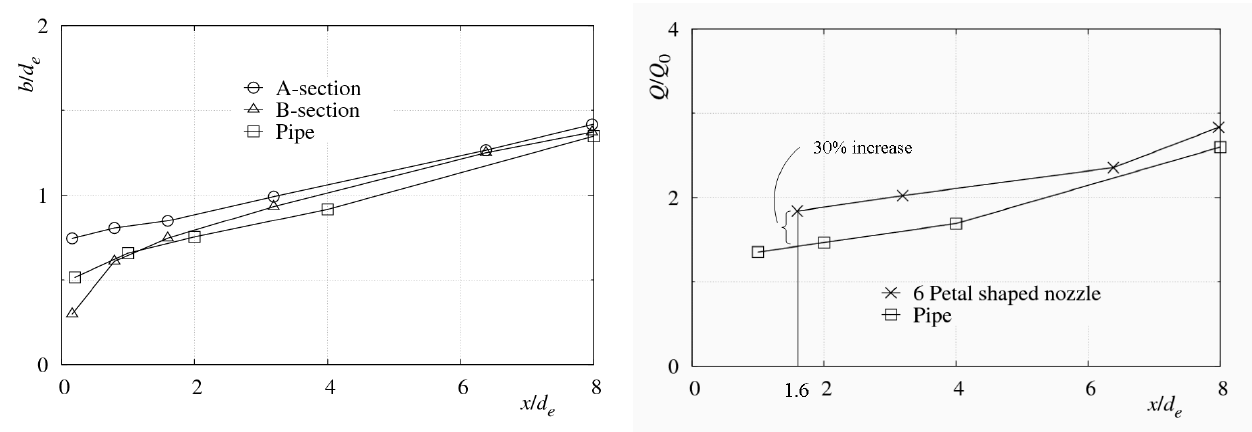
Fig.11 Spread of jet, jet width b/d (Jet edge : y at u/u